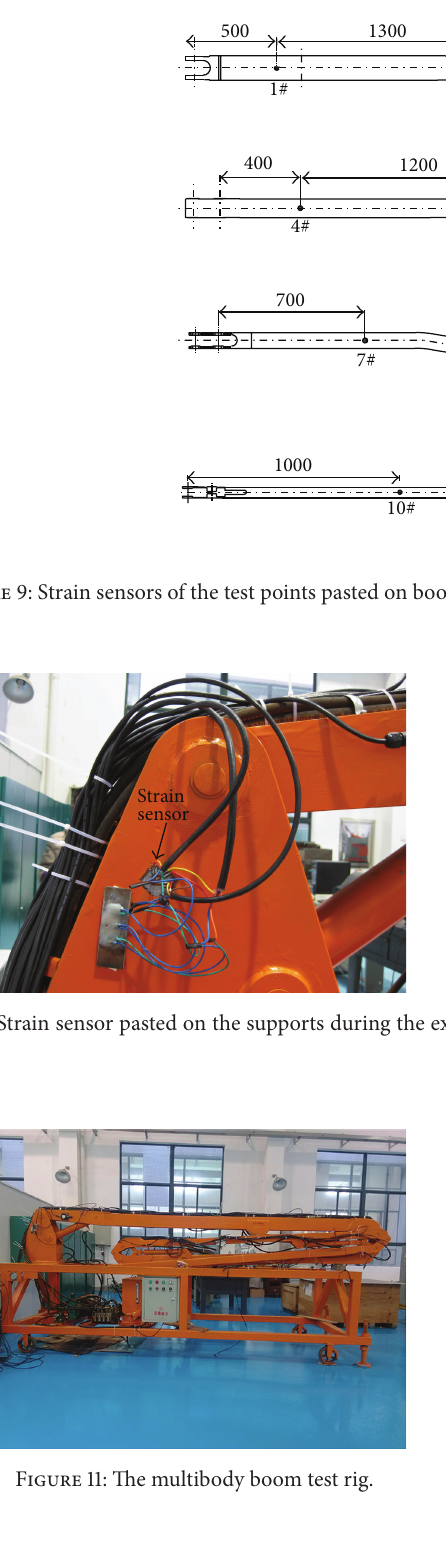
Compared with the simulated value 95 Mpa of test point 1, the error between them is about 5 Mpa. And the largest error 7. The other points’ results are both in good